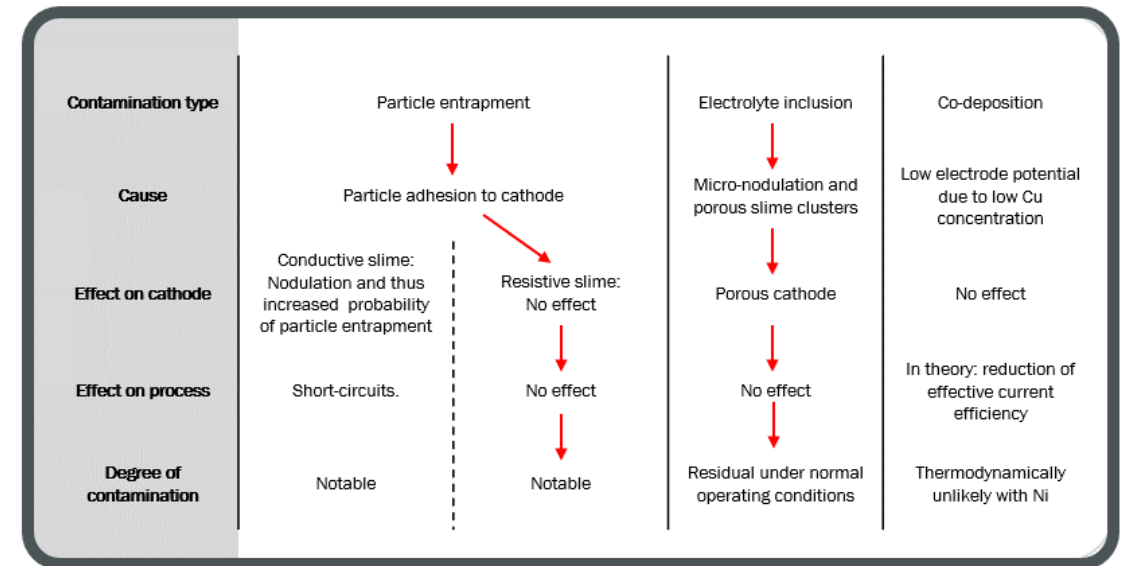
Figure 9. Pathways for Ni contamination in copper electrorefining. Red arrows mark the observed behavior of nickel.